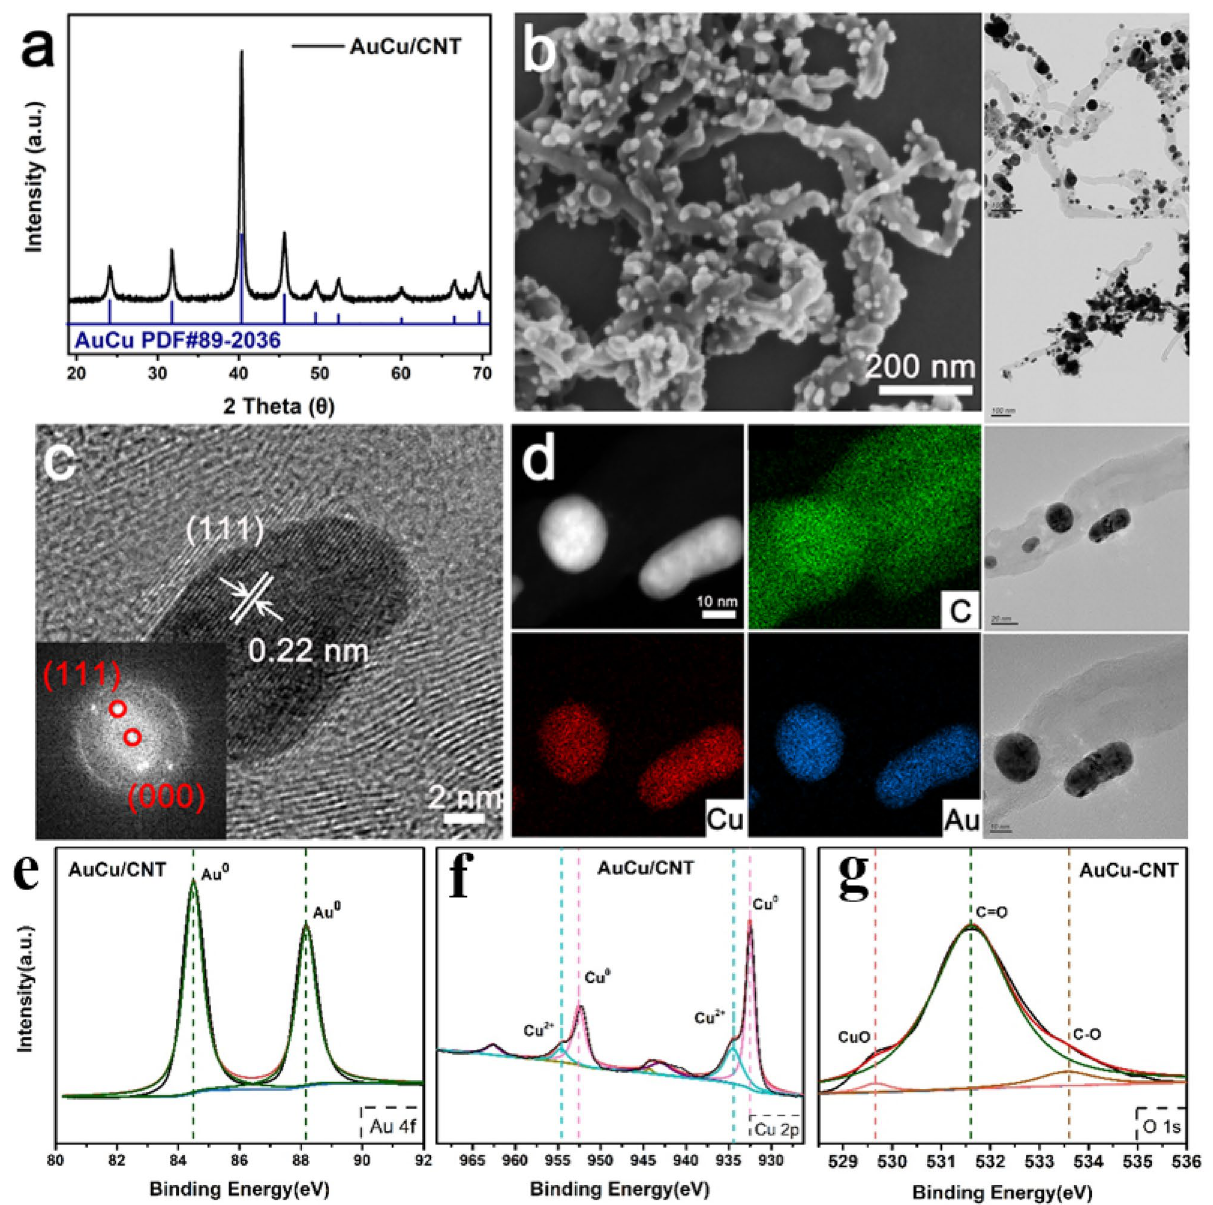
Figure 3. ( a ) XRD spectra of AuCu/CNT, ( b ) Microstructure of AuCu/CNT, ( c ) High Resolution Morphology of AuCu/CNT (The illustration is the fast Fourier transform image of selective diffraction), ( d ) HAADF-STEM image of AuCu/CNT, ( e ) Au 4f. XPS spectra of AuCu/CNT, ( f ) Cu 2p XPS spectra of AuCu/CNT, ( g ) O 1 s XPS spectra of